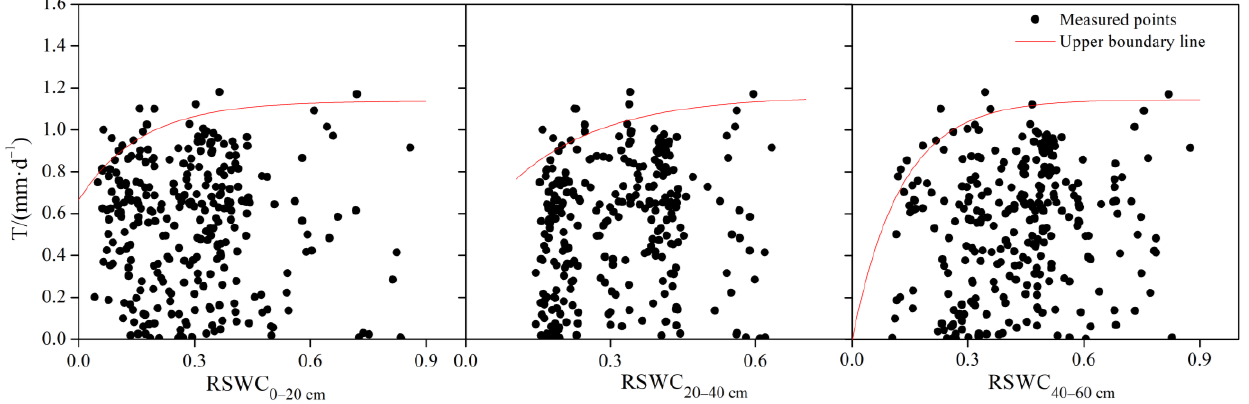
Figure 4. Response of T to different soil layers RSWC (0–20, 20–40, and 40–60 cm) from 2017 to 2019. Table 3. The response relationship of T to ET ref , LAI, and RSWC in different soil layers and their thresholds.